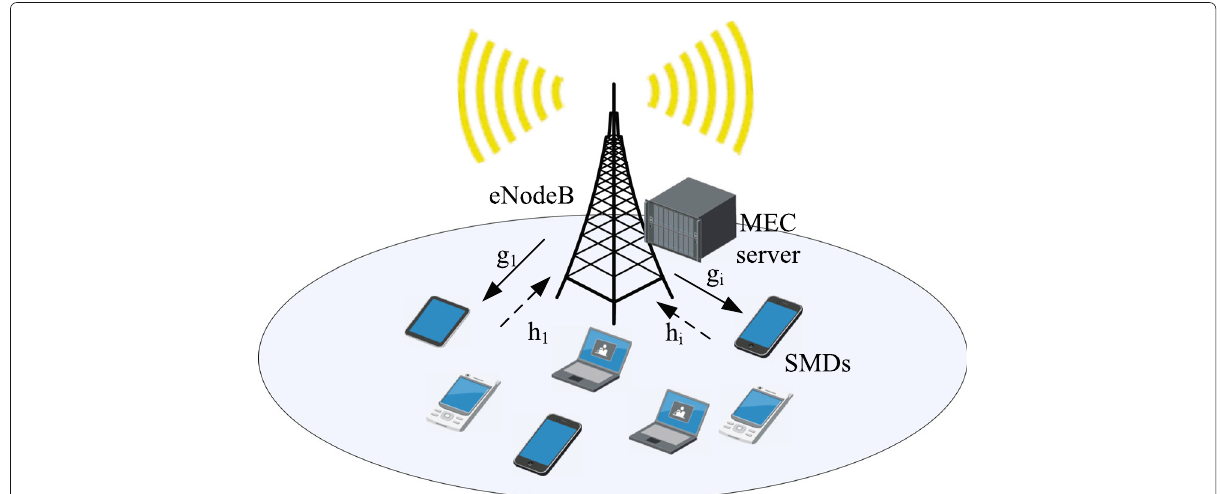
Fig. 1 System Model